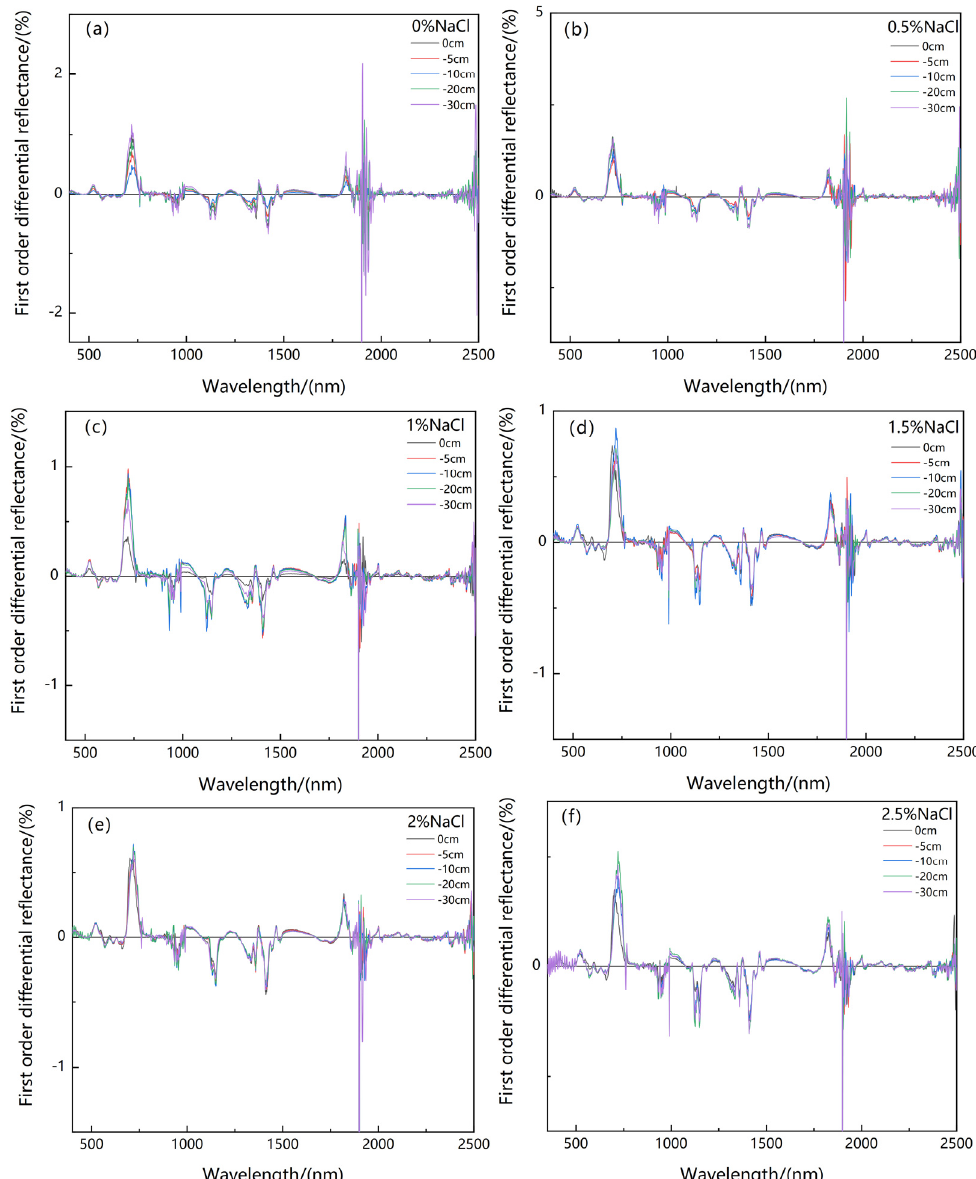
Figure 7. The change of the first-order differential reflectance spectrum under five groundwater levels (0 cm, –5 cm, –10 cm, –20 cm, and –30 cm) and six NaCl salt concentrations (0%( a ), 0.5%( b ), 1 %( c ) , 1.5% (d) , 2%( e ), and 2.5%( f )).